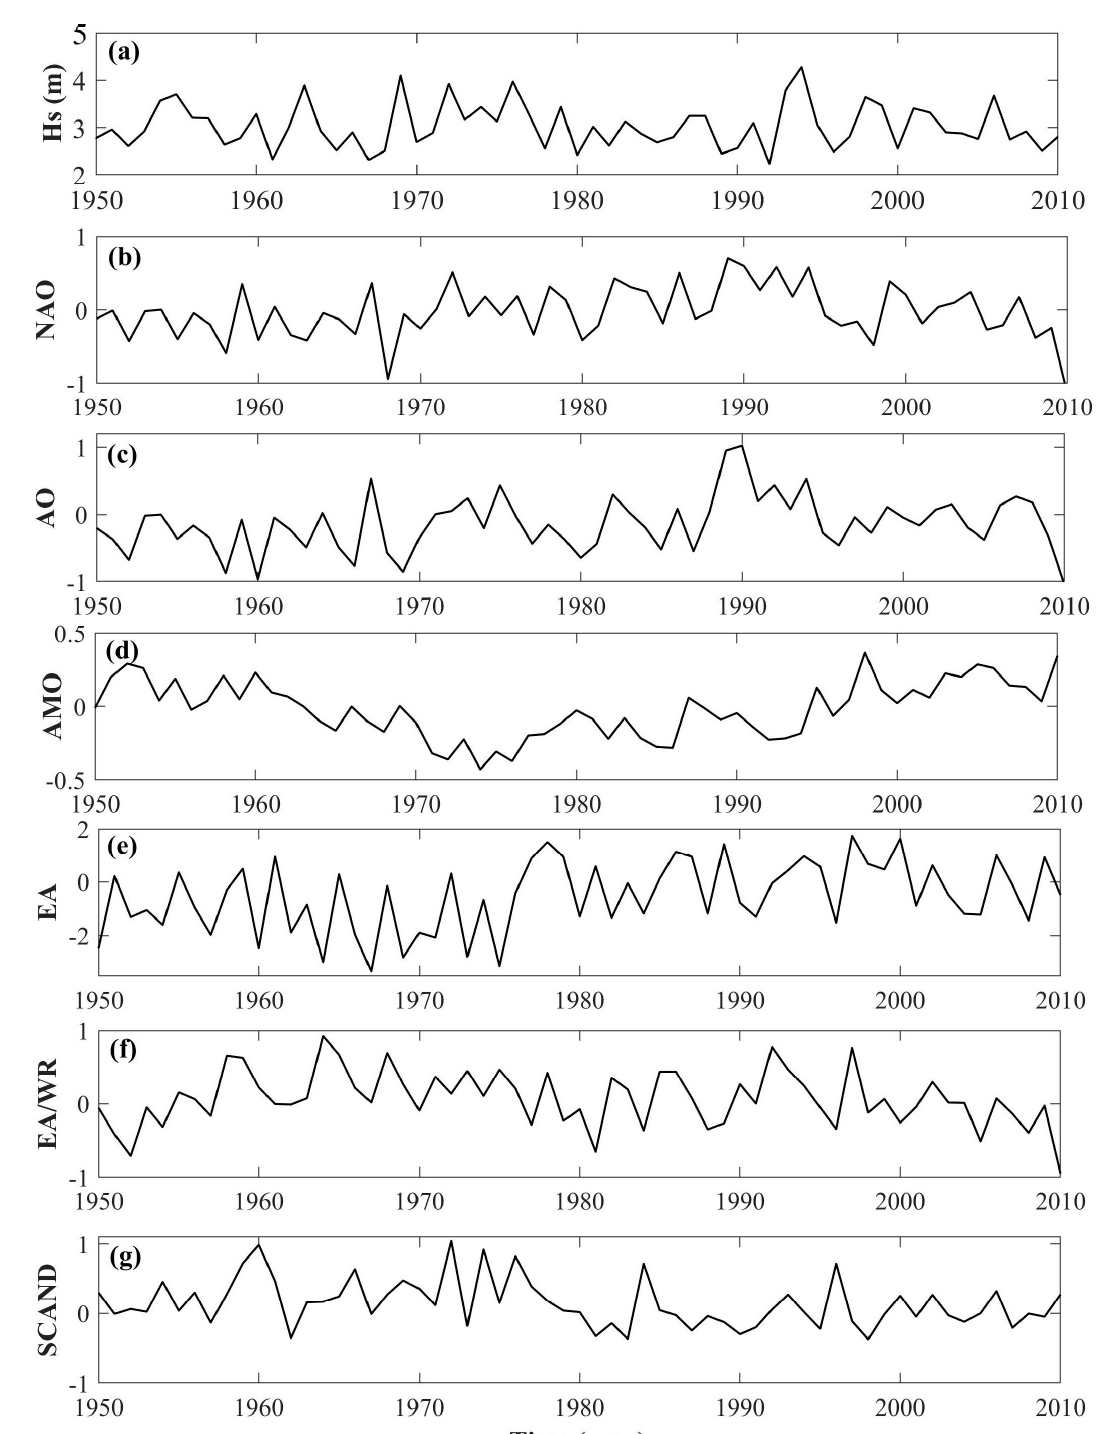
Figure 7. Variations of ( a ) 99th quantile of the significant wave height and ( b ) the North Atlantic Oscillation (NAO), ( c ) the Atlantic Multi-decadal Oscillation (AMO), ( d ) the East Atlantic Oscillation (EA), ( e ) the Arctic Oscillation (AO), ( f ) the East Atlantic-Western Russia (EA/WR) and ( g ) Scandinavian (SCAND) patterns for